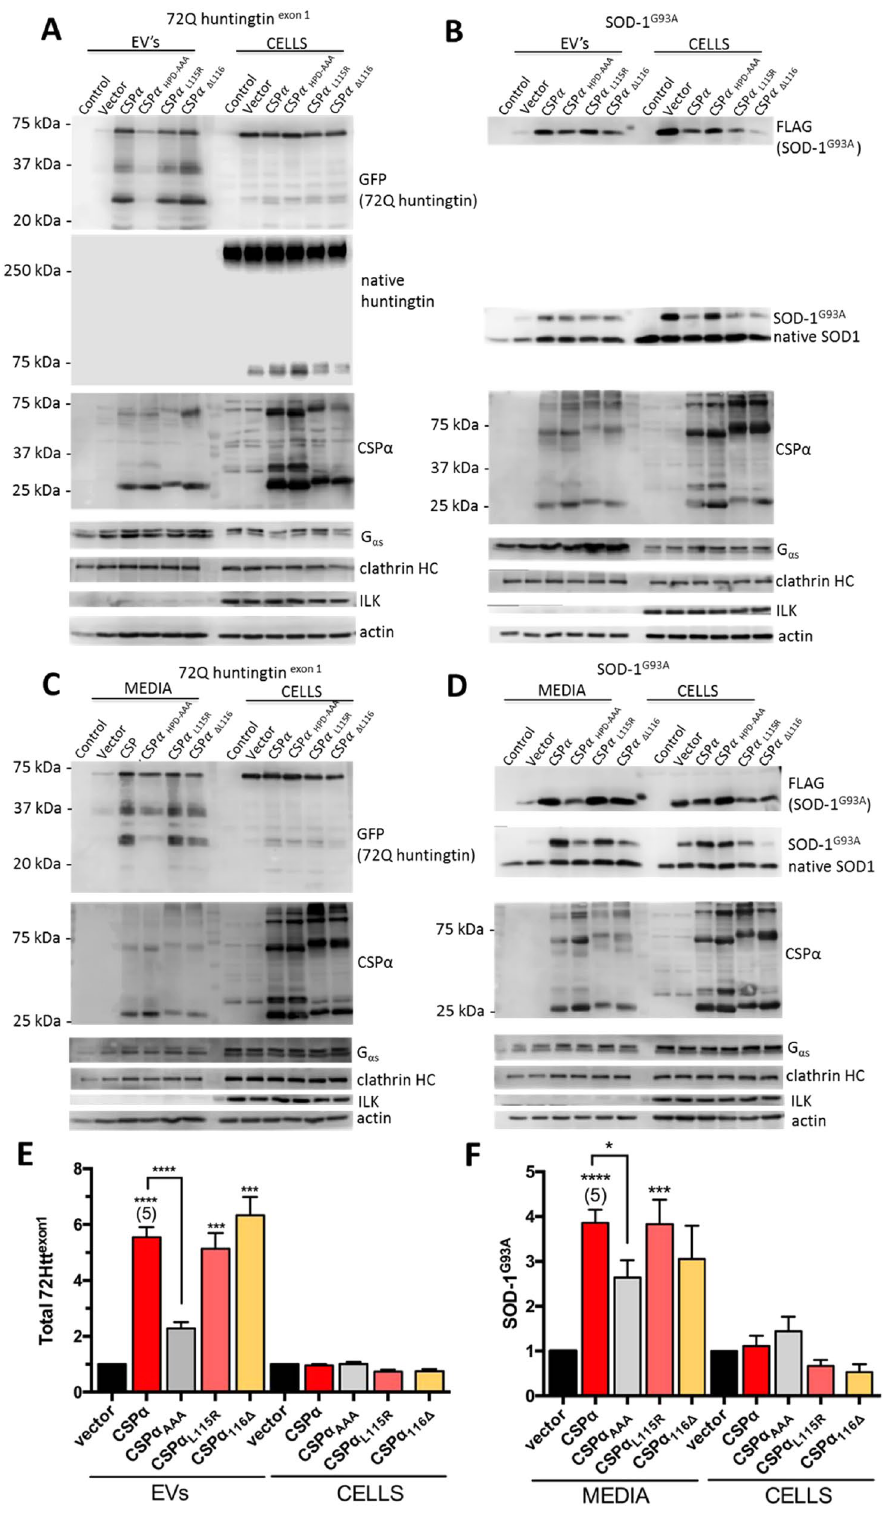
Figure 4. CSP α promotes 72Q huntingtin exon1 and superoxide dismutase-1 (SOD-1 G93A ) export. Immunoblot of EV’s and corresponding lysates (15 µ g) from cells transfected with GFP-tagged 72Q huntingtin exon1 ( A ) or FLAG-tagged SOD-1 G93A . For native huntingtin immunoblot 25 µ g of cell lystates were evaluated. ( B ) and vector, myc-tagged CSP α , CSP α HPD-AAA , CSP α L115R , or CSP α L116 and probed with the indicated antibodies. ∆ 2.5 µ g of the indicated cDNA was transfected. ( C , D ) Immunoblot of media and corresponding lysates (15 µ g). ( E , F ) Quantification of GFP-tagged 72Q huntingtin exon1 in EV’s and FLAG-tagged SOD-1 G93A in media, normalized to actin ( **** P < 0.0001; *** P < 0.001, * P <